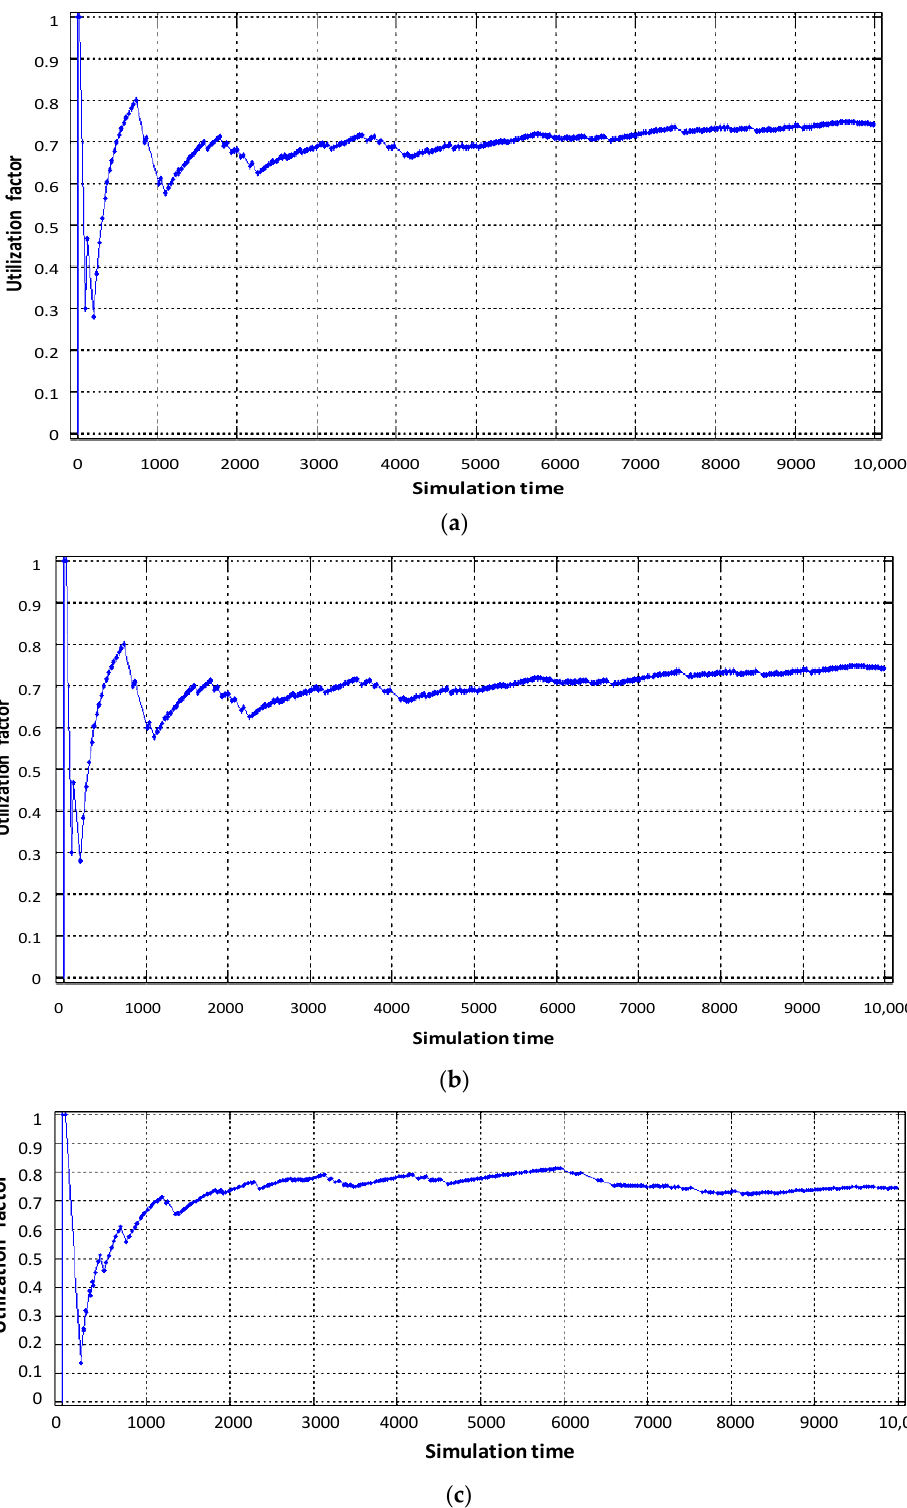
Figure 7. Service device loading of the virtual router with flows: ( a ) video, ( b ) voice, ( c ) data.